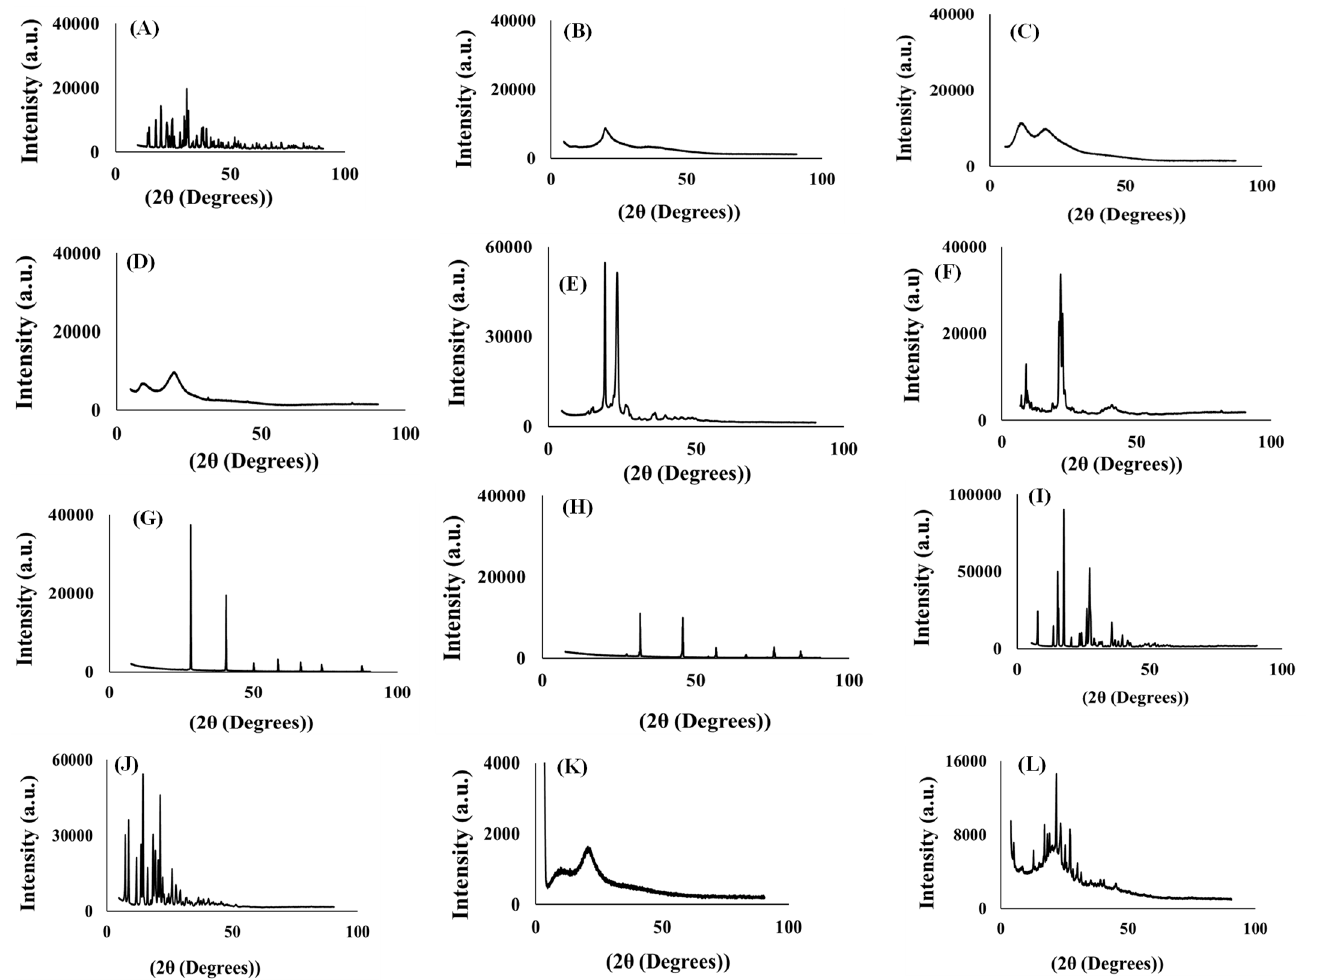
Figure 5. X-ray diffraction of ( A ) xylitol, ( B ) Primellose ® , ( C ) polyvinylpyrrolidone, ( D ) methylcellulose, ( E ) Kolliphor ® , ( F ) magnesium stearate, ( G ) potassium chloride, ( H ) sodium chloride, ( I ) pyrazinamide, ( J ) rifampicin, ( K ) placebo and ( L ) the drug-loaded formulation.